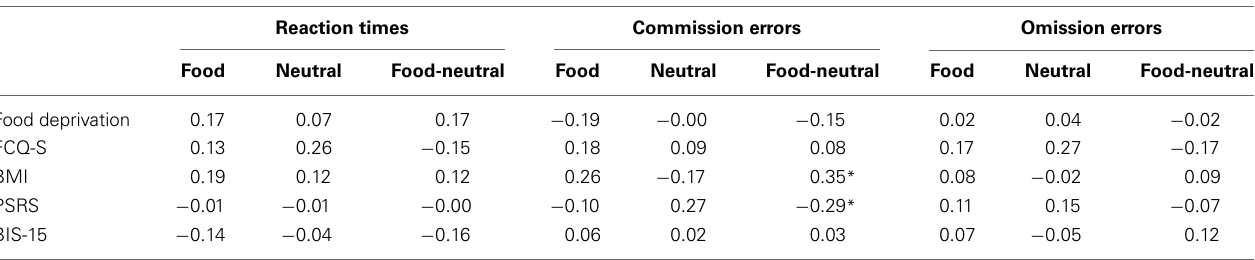
FIGURE 2 | Task performance as a function of target type and block type in study 1. Displayed is (A) reaction time in go-trials in ms, (B) number of commission, and (C) omission errors. Error bars indicate standard errors of the mean. ∗∗∗ p < 0 . 001, ∗ p < 0 . 05.